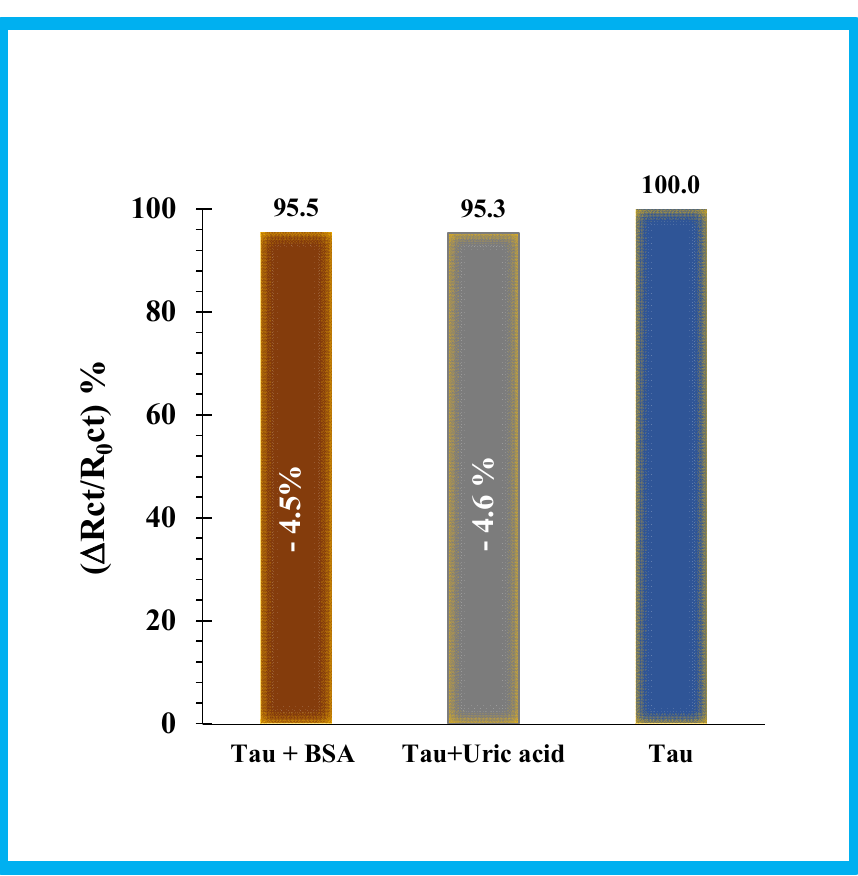
Figure 5. Selectivity test of the sensor by competitive method; signal for mixture of Tau and BSA, mixture of Tau and Uric acid, and only Tau protein.